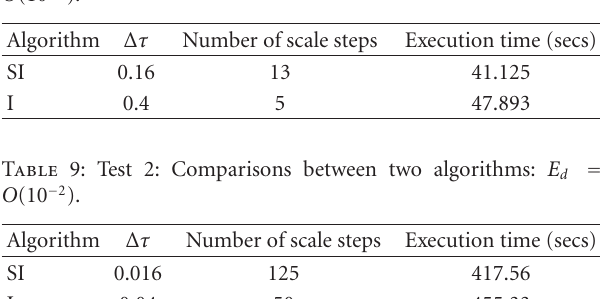
Figure 5: Algorithm SI. Behavior of the relative residual (cid:12) r i (cid:12) 2 / (cid:12) r 0 (cid:12) 2 versus 25 scale steps. Δ τ SI = 0 . 016. Table 8: Test 2: Comparisons between two algorithms: E d = O (10 − 1 ).